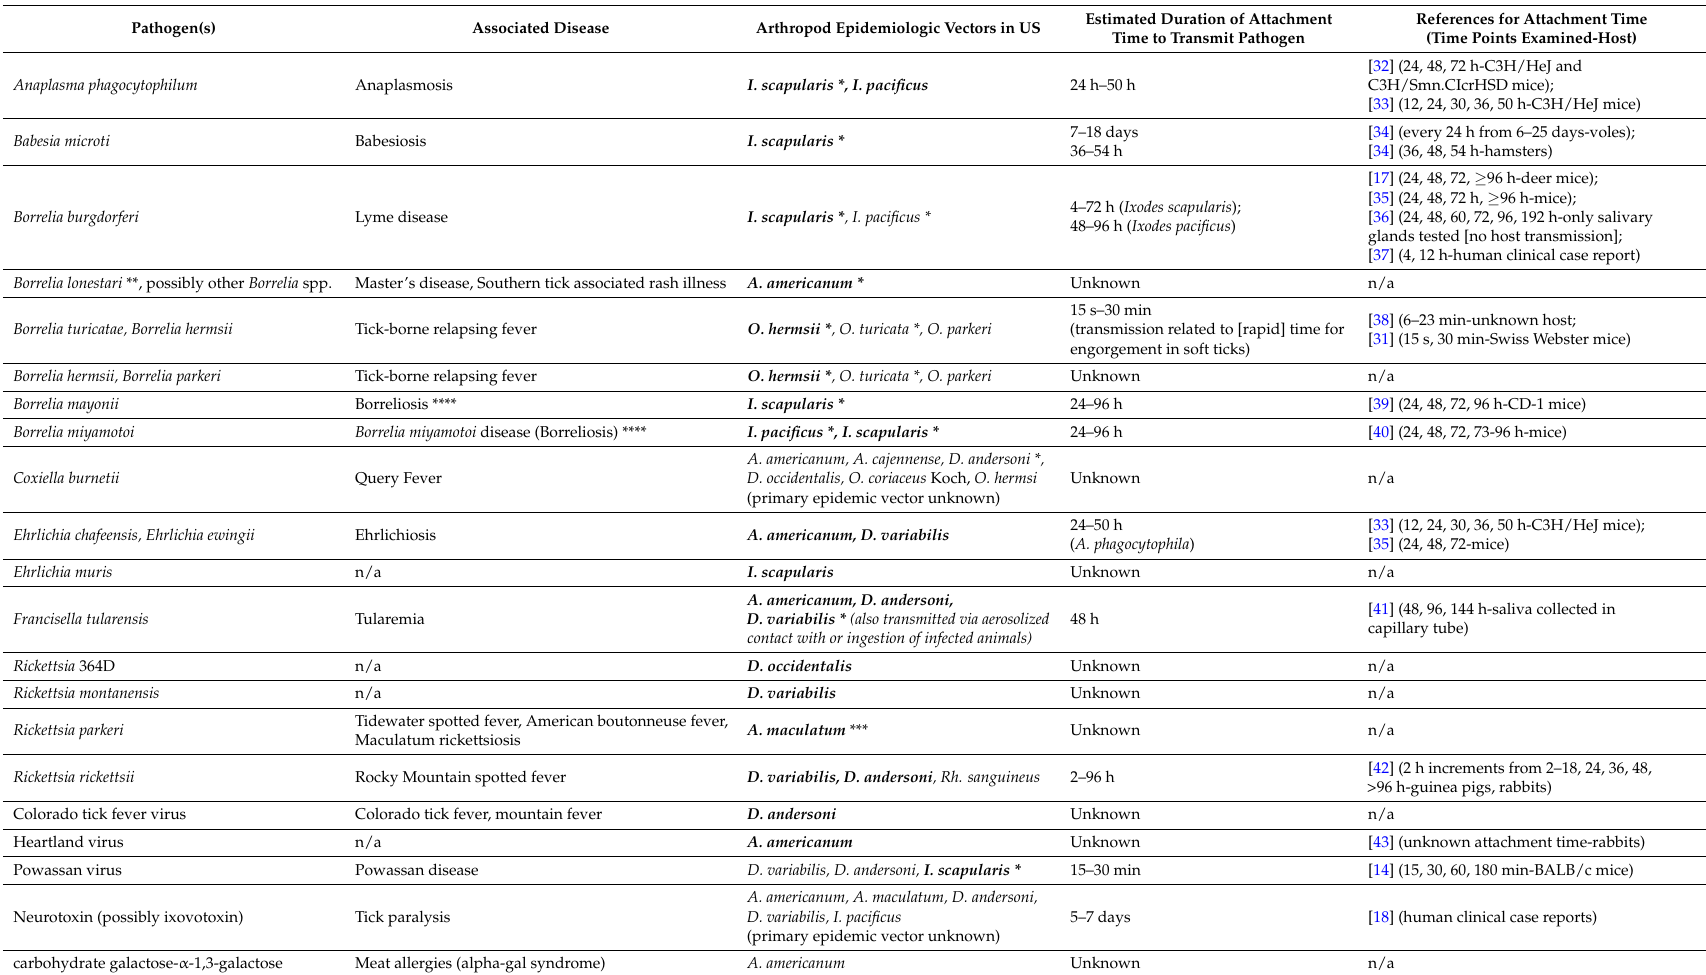
Table 1. Summary of attachment times reported in publications. Primary known US vector(s) are indicated in